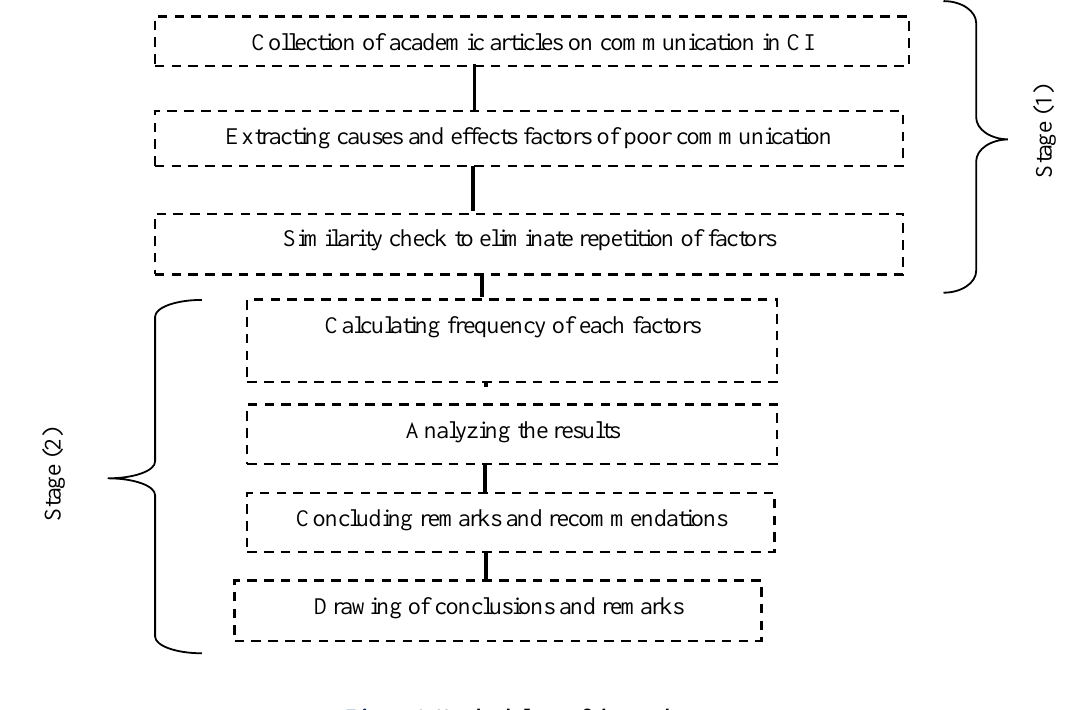
Figure 1. Methodology of the